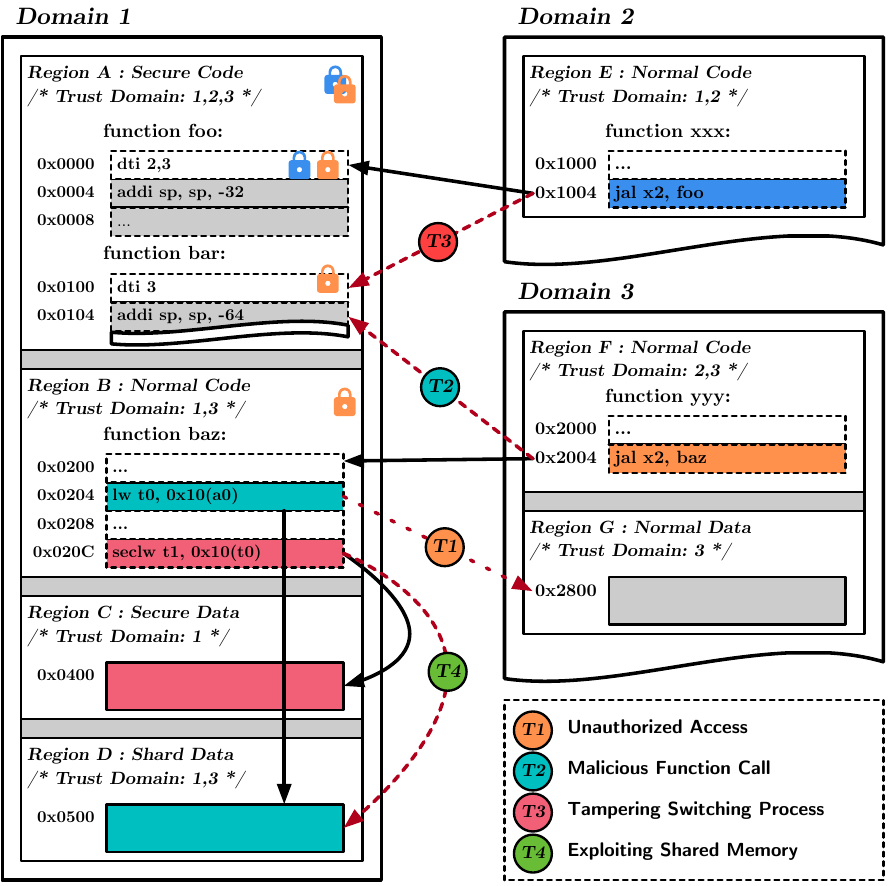
Figure 4. Domain protection functionality in